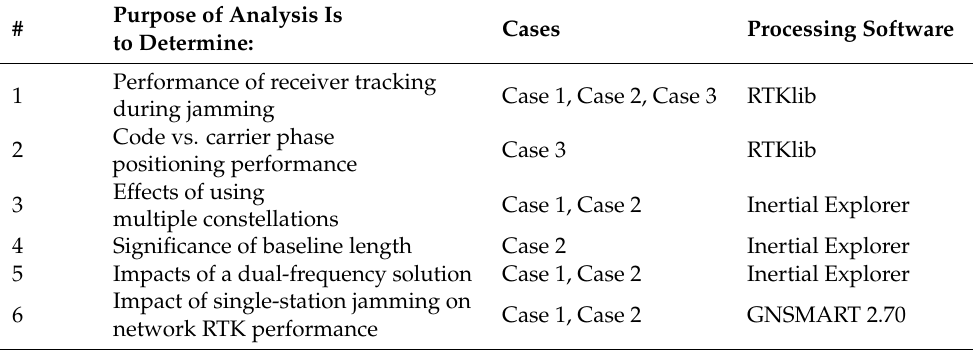
Table 2. Analyses of the jammed